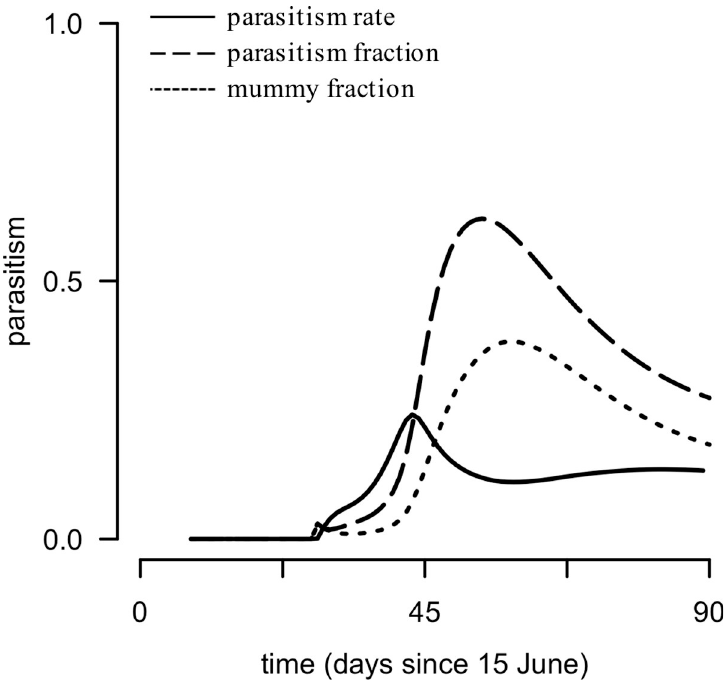
Fig 4. Comparing measures of parasitism in model simulations. Solid line: parasitism rate (d − 1 ); dashed line: parasitism fraction ( × 100 = percent parasitism [%]); dotted line: mummy fraction.